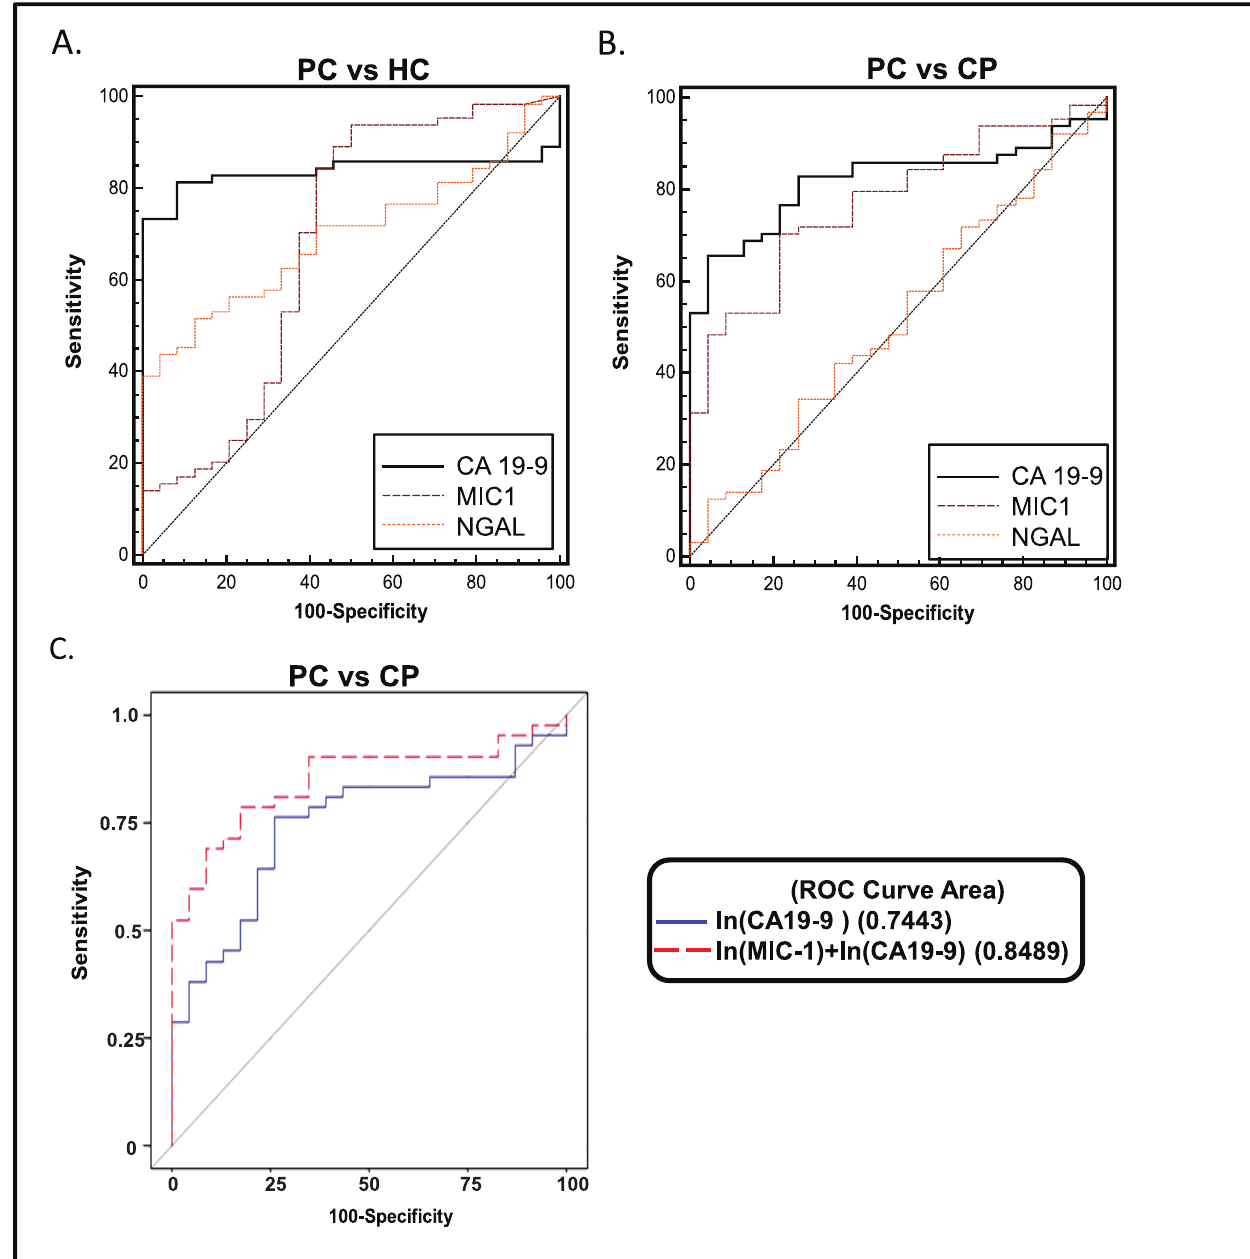
Figure 2. Reciever Operating Chacteristic curves comparing NGAL, MIC-1, CA19-9 for differentiating PC from HC (panel A) and CP (panel B) and combination of CA19-9 and MIC-1 in differentiating treatment naı¨ve resectable PC from CP. The combined use of MIC-1 with CA 19-9 significantly improved the sensitivity and accuracy in differentiating resectable PC from CP (AUC=0.85 Vs 0.74, p=0.029, C.I. 0.76–0.94) in comparison to CA19-9